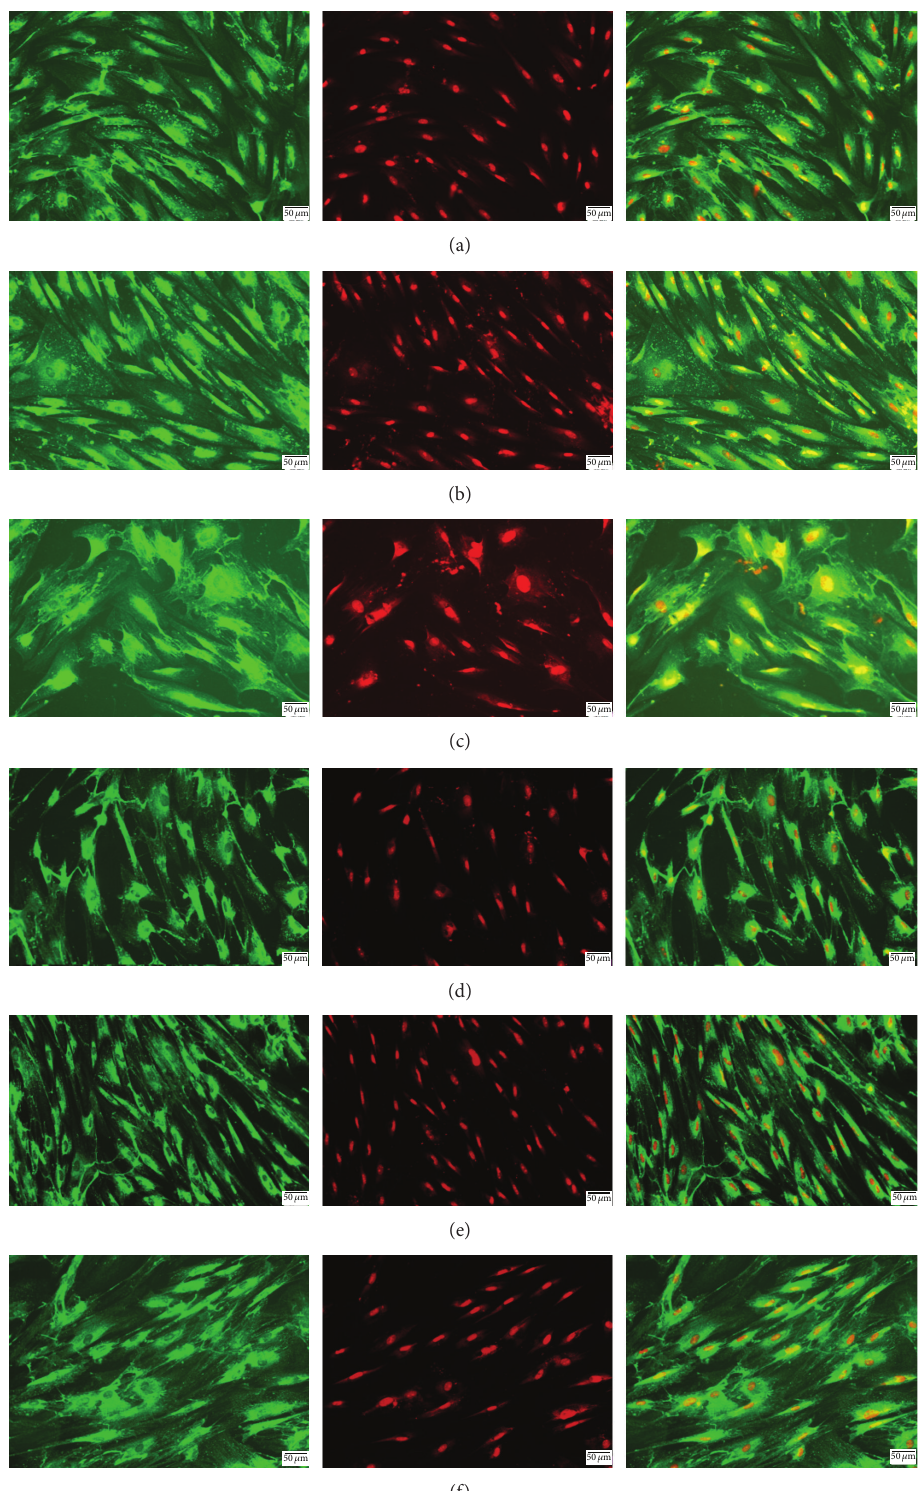
Figure 6: Immunofluorescence for the expression of type I collagen in guinea pig scleral fibroblasts. (a) SC group. (b) SC group added with DKK-1. (c) SC group added with TGF- 𝛽 1 neutralizing antibody. (d) FDM group. (e) FDM group added with DKK-1. (f) FDM group added with TGF- 𝛽 1 neutralizing antibody (green for type I collagen, red for PI) (original ∗ 200, bar = 50 𝜇